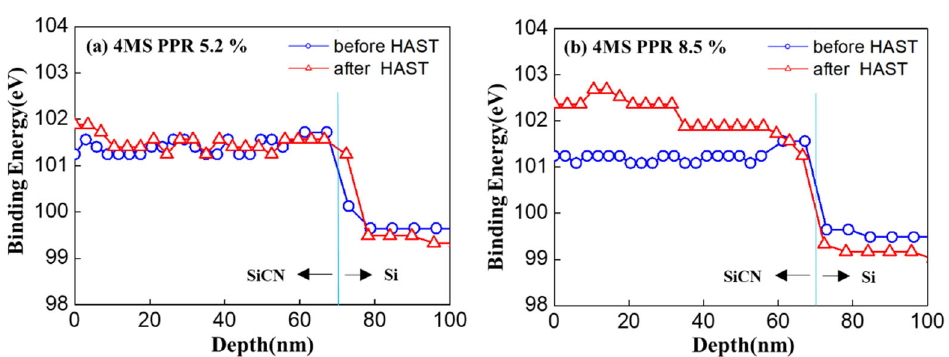
Figure 11. Comparison of the changes in the Si bond (Si2p) in the XPS analysis before and after HAST at ( a ) 4MS PPR of 5.2% and ( b ) 4MS PPR of 8.5%. at ( a ) 4MS PPR of 5.2% and ( b ) 4MS PPR of